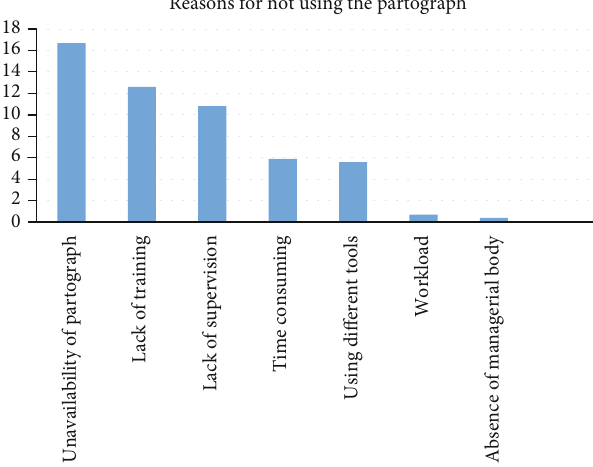
Figure 1: Reasons for not using the partograph by obstetric care providers of a public health institution in Wolaita Zone, SNNPR, Ethiopia, 2017. Table 2: Knowledge of obstetric caregivers on partograph utilization in Wolaita zone, Southern Ethiopia, 2017 ( n = 269